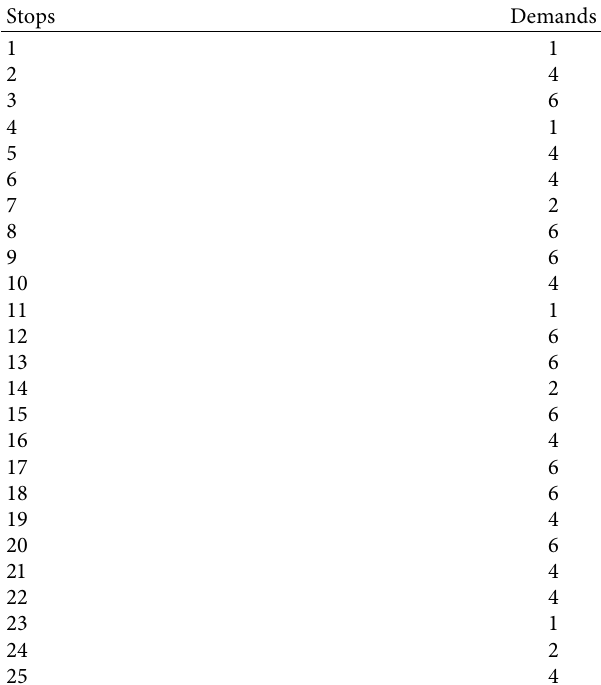
Table 2: Expected demand for each bus stop during the entire operation